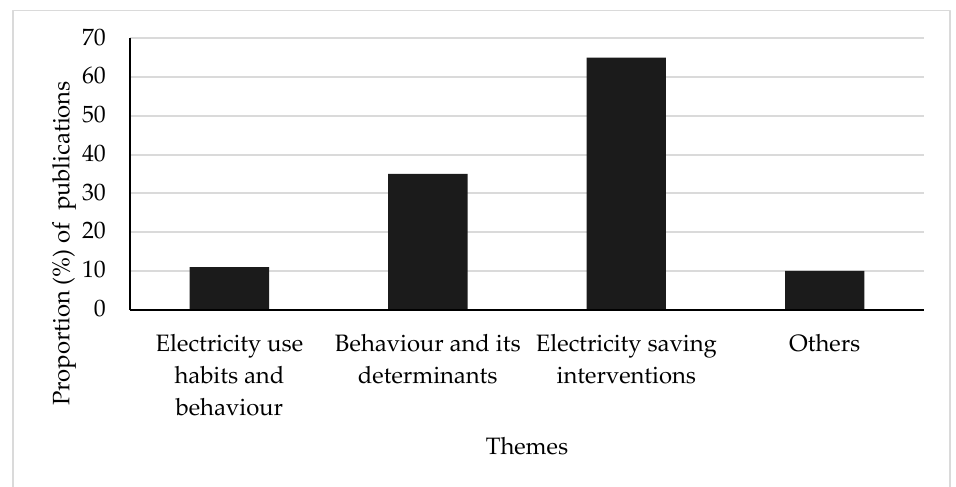
Figure 3. Research focus of the reviewed publications.